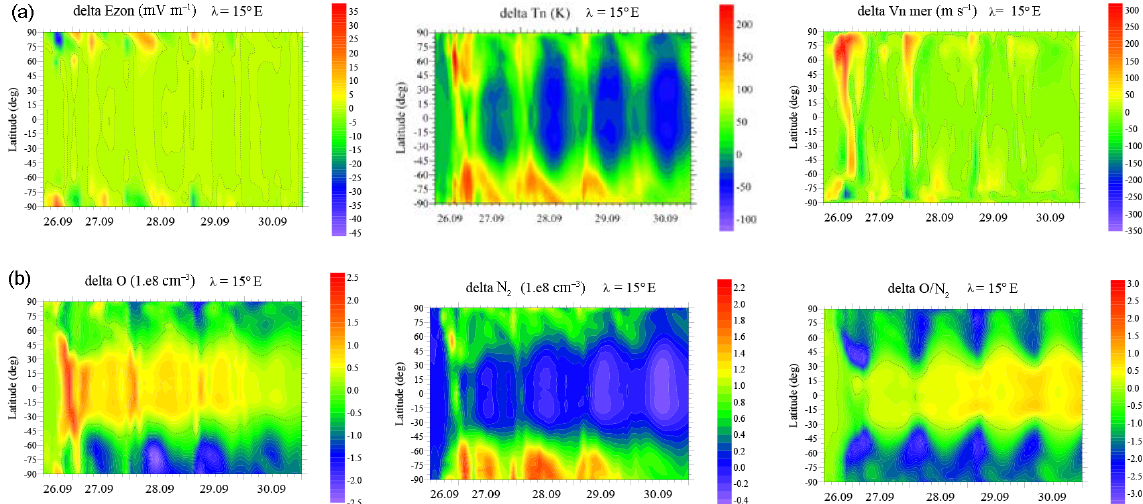
Figure 6. The same as in Fig. 5, but for 15 ◦ E